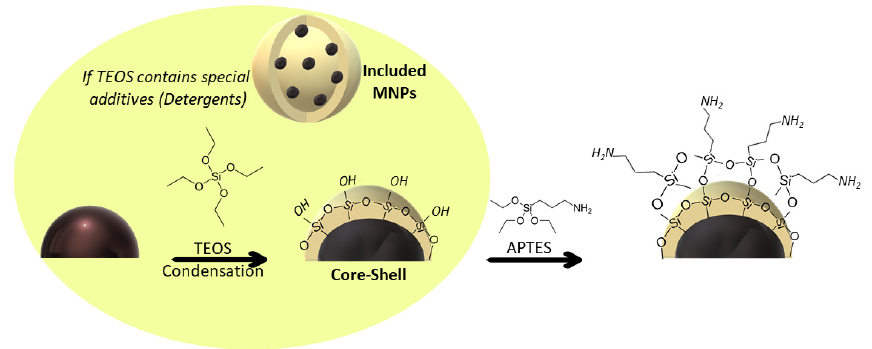
Figure 5. Synthesis of two types of silicaMNCs. Tetraethoxysilane (TEOS) forms a silicon dioxide shell. The simple hydrolysis of TEOS leads to a core–shell type structure. The presence of detergents, such as a cetrimonium bromide (CTAB), provides MNP encapsulation. (3-Aminopropyl)triethoxysilane (APTES) is a primary reagent for amino group surface functionalization.